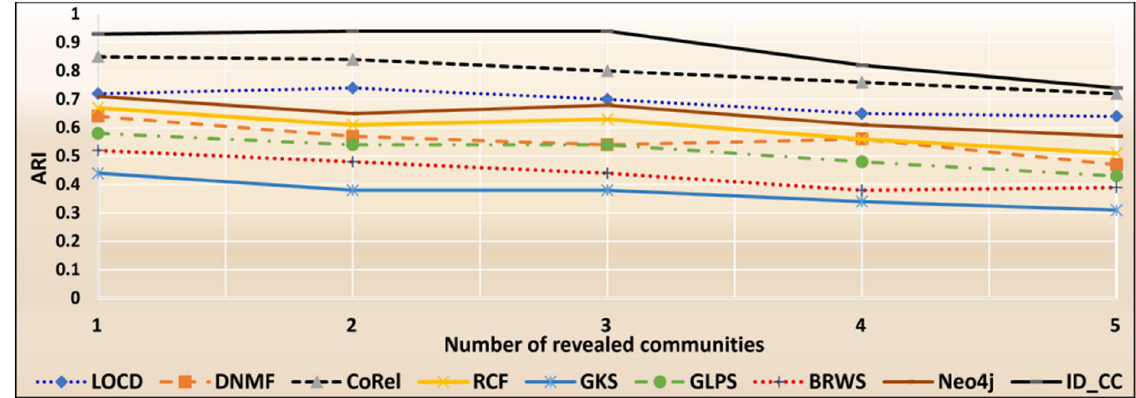
Fig 29. The accuracy of each method in terms of ARI for detecting the Facebook Social circles cross-communities resulted from the overlapping of m number of communities ( m = 1, 2, ... , 5).